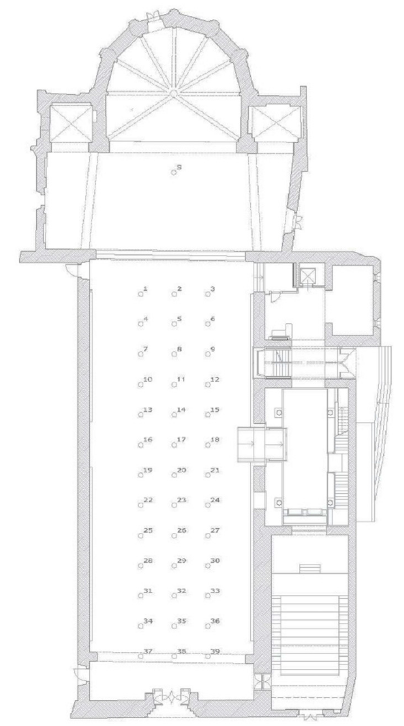
Figure 3. Source and receiver positions inside S. Dominic of Foligno.